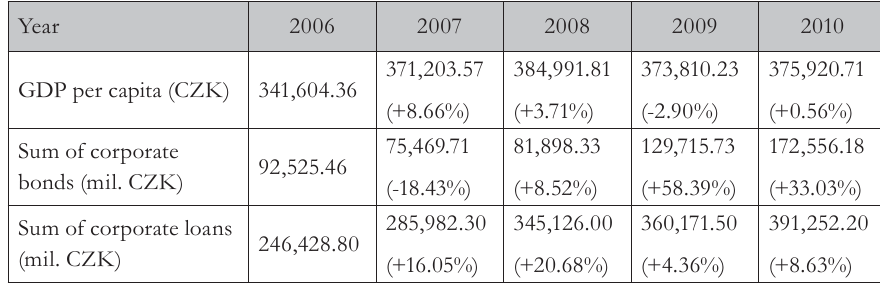
Tab. 2 - The development of GDP per capita and volumes of corporate bonds and